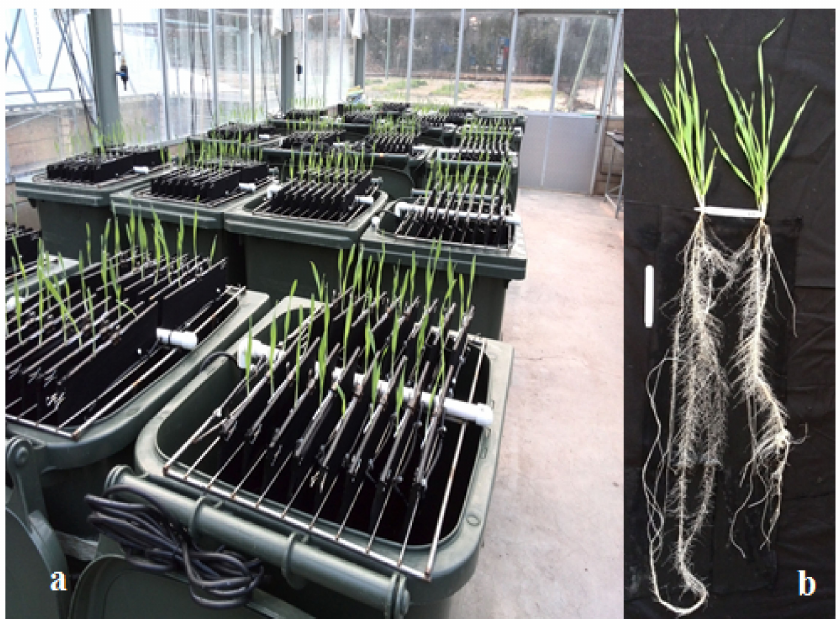
Figure 1. Layout of barley plants grown in the semi-hydroponic phenotyping system ( a ), and plants of two barley genotypes with contrasting root systems grown for 30 days after transplanting ( b ) in a temperature-controlled glasshouse. Bar = 10